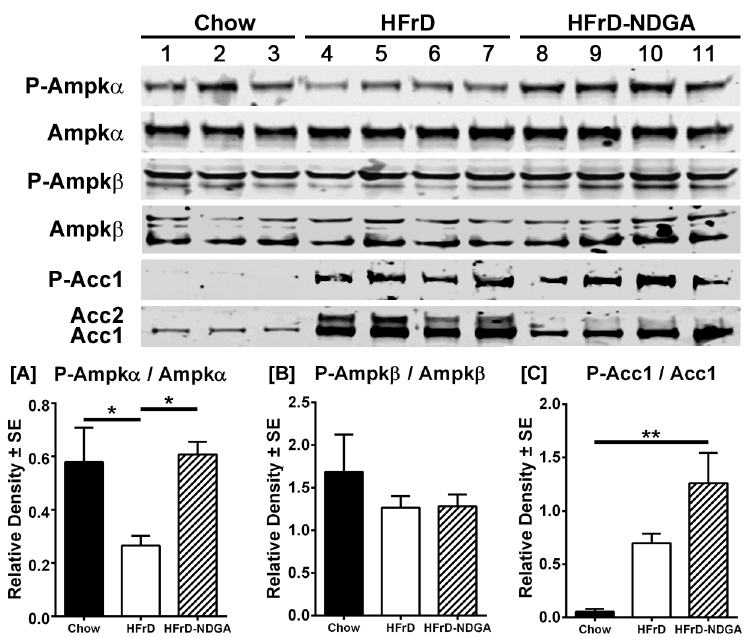
Fig 6. Effect of NDGA treatment by oral gavage on expression and phosphorylation of AMPK α , AMPK β , ACC1 and ACC2. After 8 weeks of chow, HFrD feeding or HFrD feeding-NDGA treatment, animals were fasted for 4h before tissue collection and liver homogenates were immunoblotted for P-AMPK α , total AMPK α , P-AMPK β , total AMPK β , P-ACC1 and total ACC1 and ACC2. Representative blots for these proteins are shown. Data presented are means ± SE of 3 – 4 individual samples. * P < 0.05; ** P < 0 . 01; *** P < 0 . 001 . Raw data and statistics are listed in S1 Dataset.